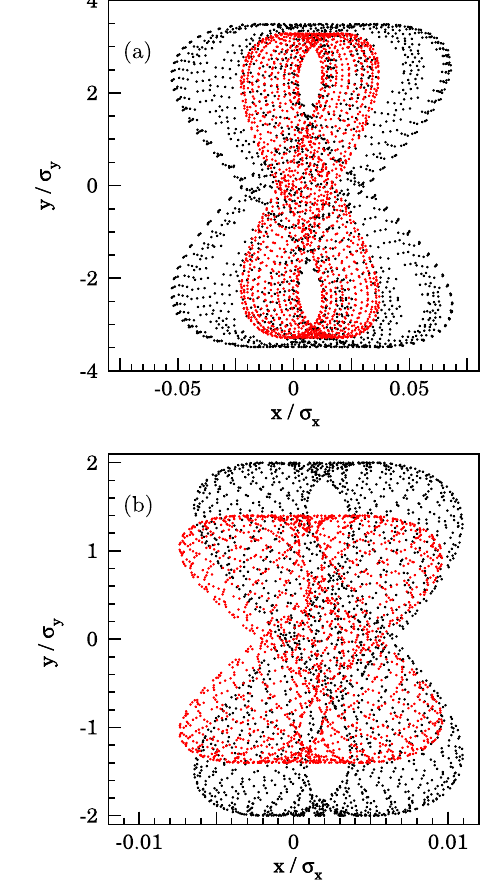
FIG. 13. (a) Resonant orbits of two particles (black & red) at the longitudinal position z ¼ z 0 ¼ 0 . (b) Resonant orbits for two particles (black & red) at longitudinal position z ¼ 1 . 5 σ z and z 0 ¼ 0 . The synchrotron motion is kept